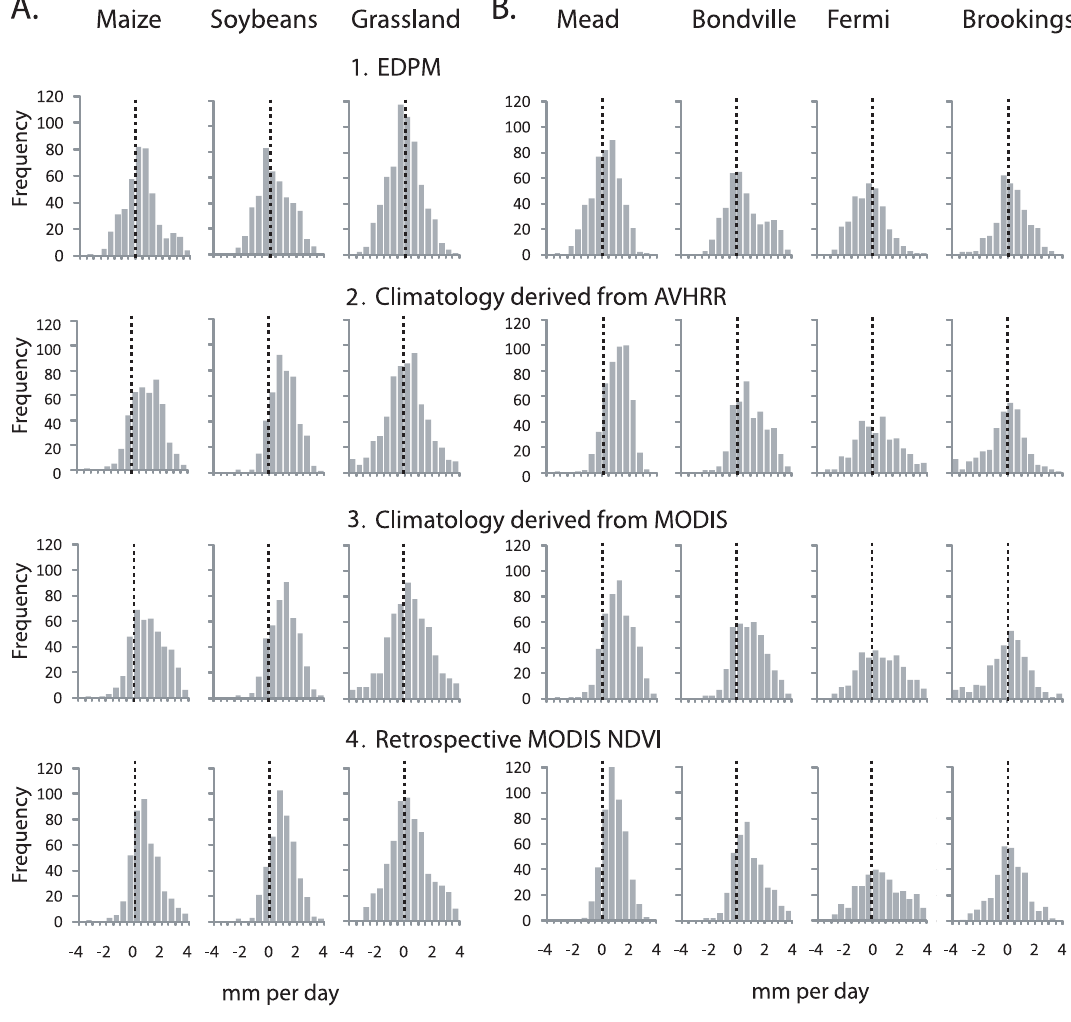
Fig. 3. Histograms of differences between modeled daily ET a estimates and flux tower observations structured by vegetation/crop type (A) and by location (B) . Dashed line marks 0 difference point where histograms are expected to be symmetrically